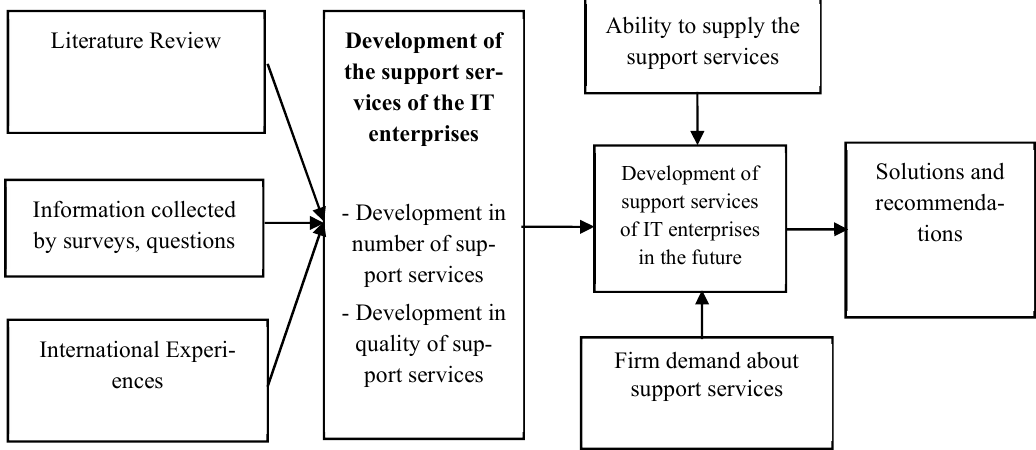
Fig. 2. Research process to develop services to support information technology enterprises in Vietnam